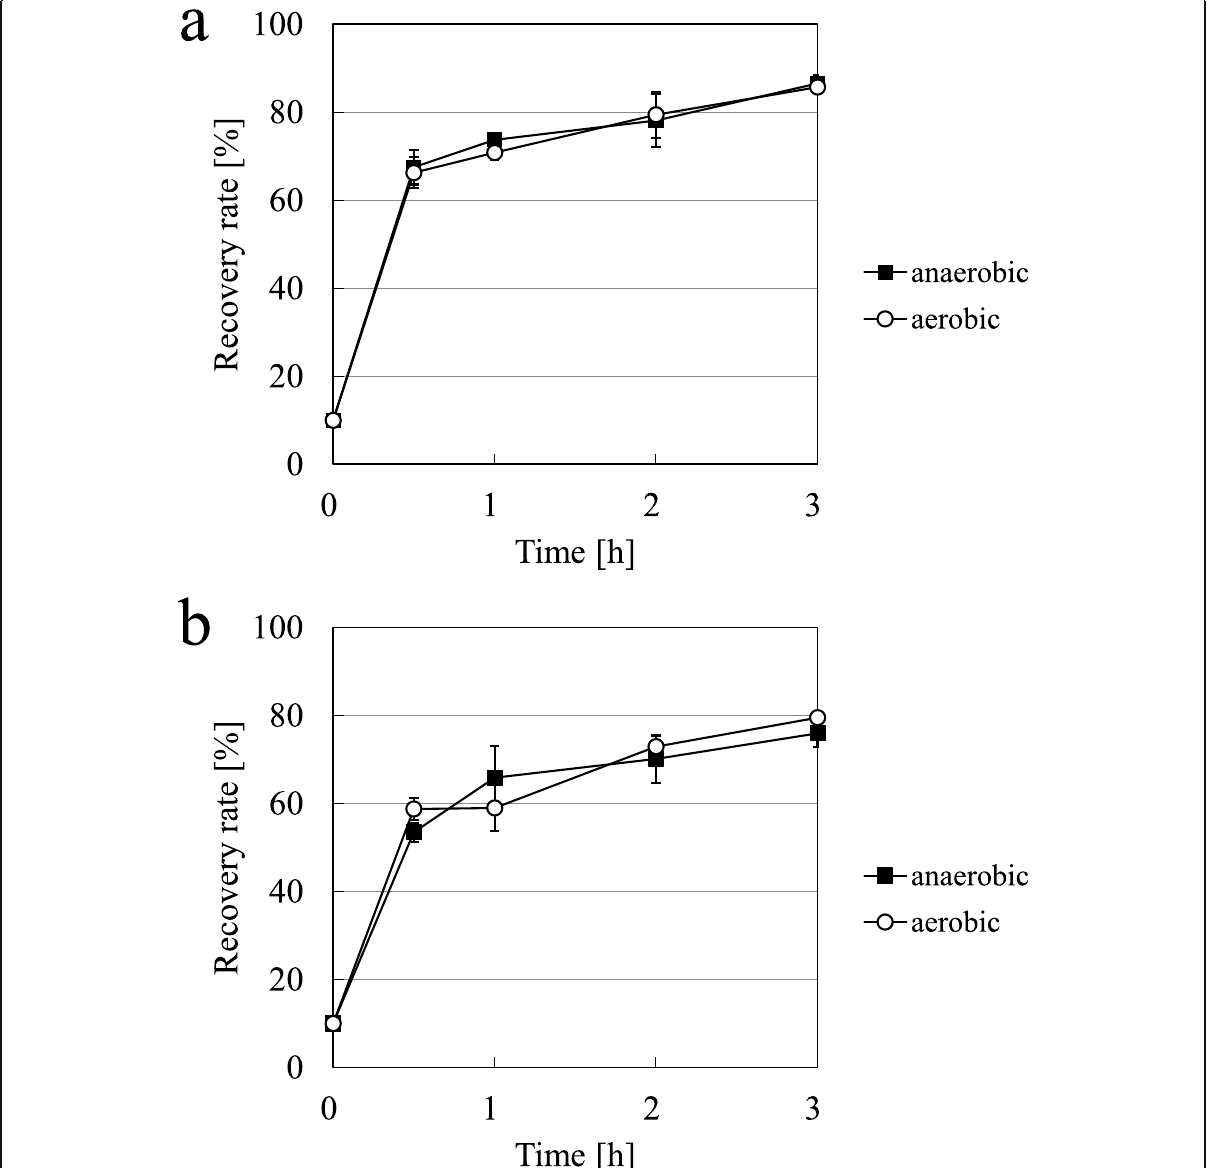
Fig. 3 Recovery rate of D. salina cells in gravity sedimentation under aerobic and anaerobic conditions. The recovery rates were examined at the indicated intervals for carotenoid-accumulating cells ( a ) and normal cells ( b ) under aerobic conditions ( ○ ) and anaerobic conditions ( ■